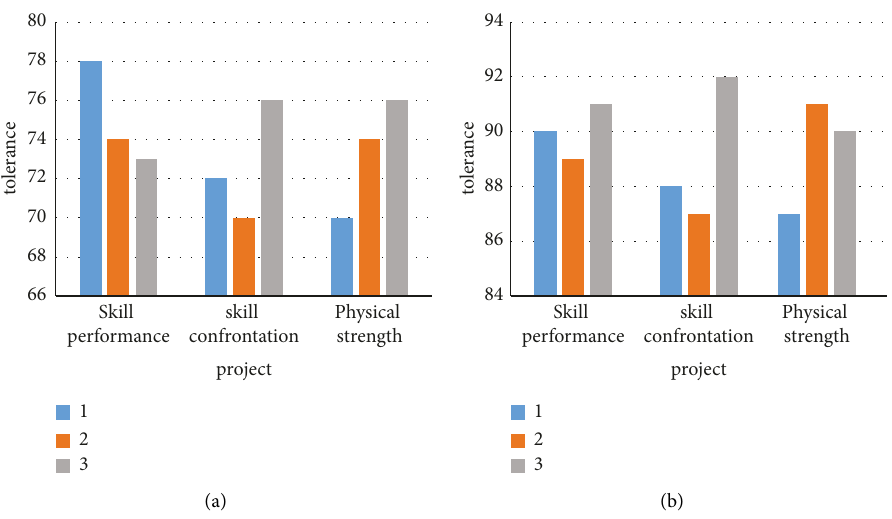
Figure 7: Tolerance comparison. (a) Before training. (b) After machine learning algorithm training.